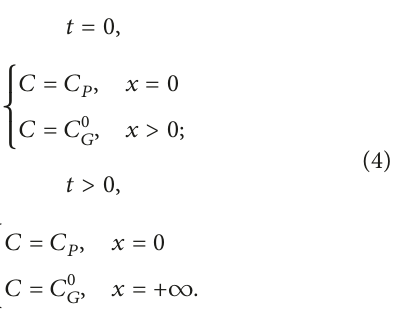
Initial and boundary